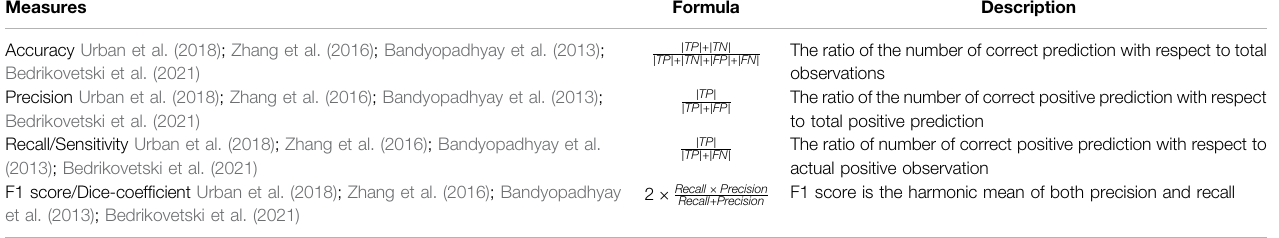
TABLE 2 | Performance measures for evaluating the detection model. Measures